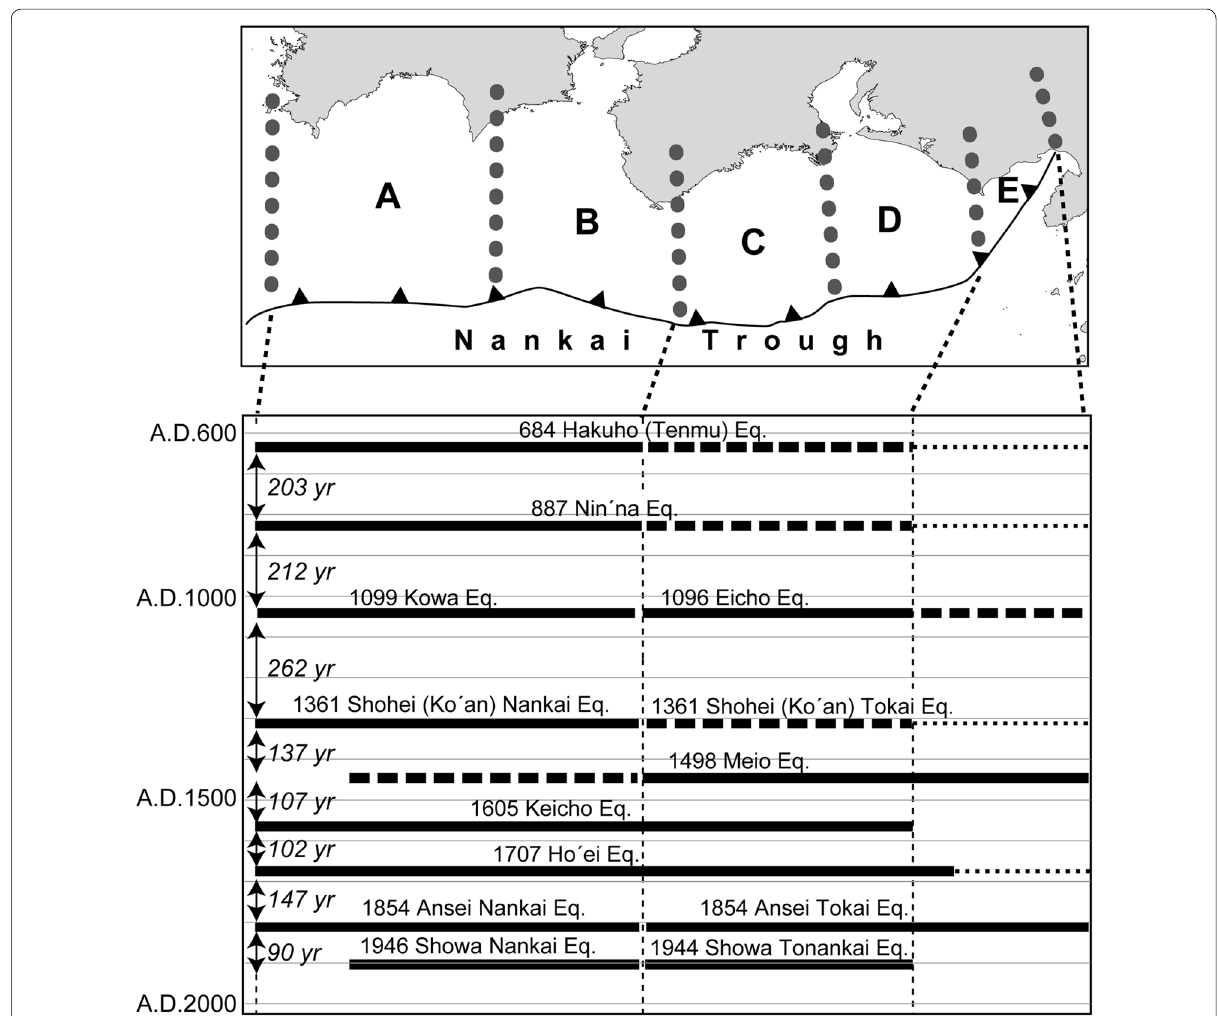
Fig. 4 Ages and rupture areas of historical earthquakes of the Suruga–Nankai Trough. The Suruga–Nankai Trough is divided into A to E segments. Solid lines are rupture areas from Ishibashi and Satake (1998), broken lines are probable ruptures from Ishibashi (2004), and thin dotted lines in segment E are possible ruptures from Ishibashi